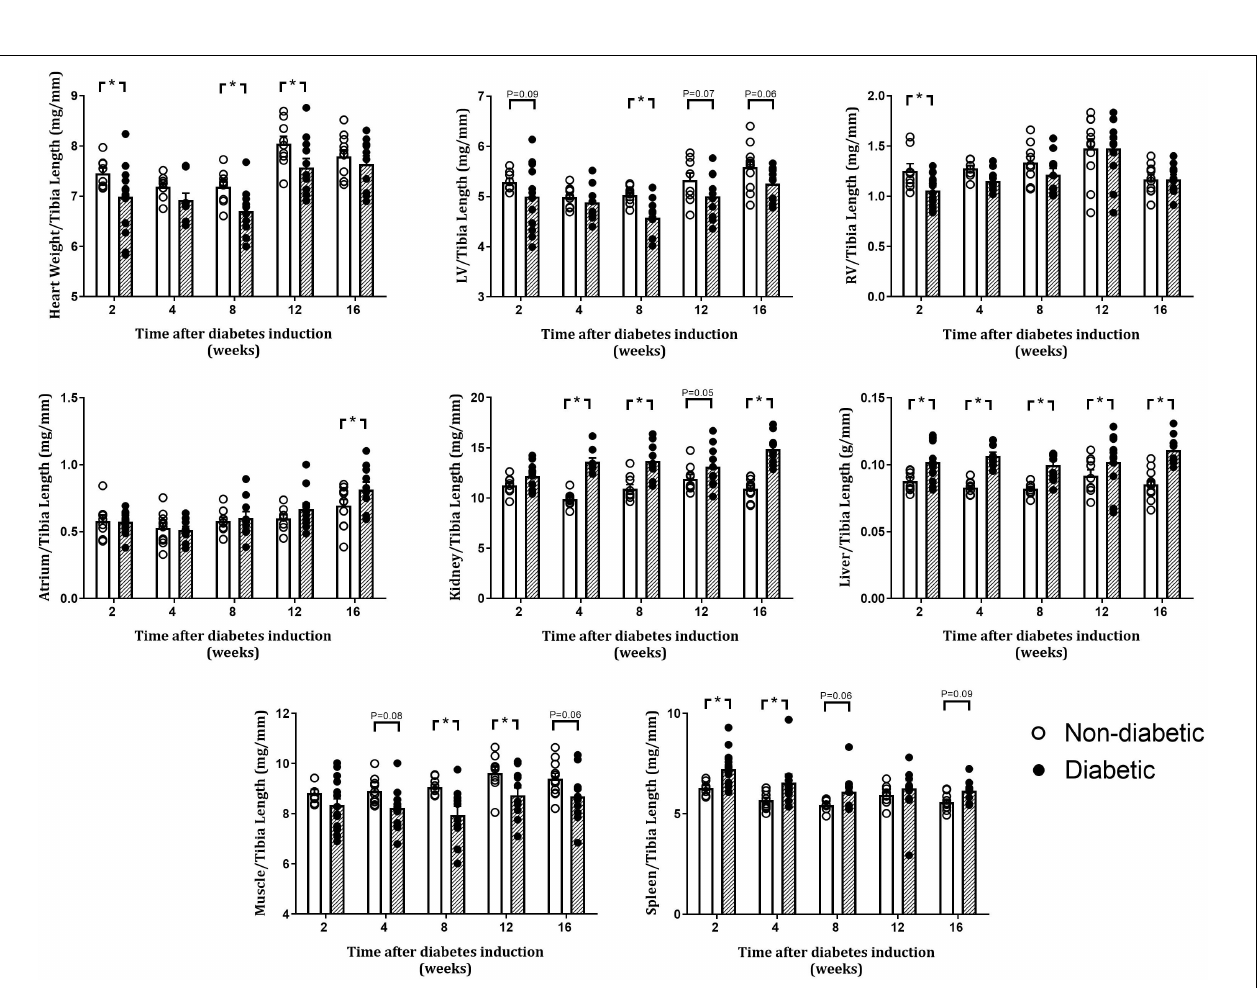
FIGURE 2 | Organ weights relative to tibia length at endpoint. Data are presented as mean ± SEM. * P < 0.05 vs age-matched non-diabetic mice (two-way ANOVA with Benjamini and Hochberg post hoc test). n = 8–15/group (refer to Supplementary Figure S1 ).